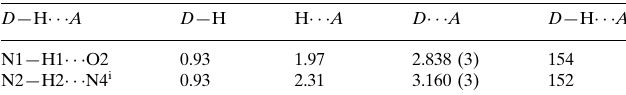
Hydrogen-bond geometry (A˚ , (cid:2)